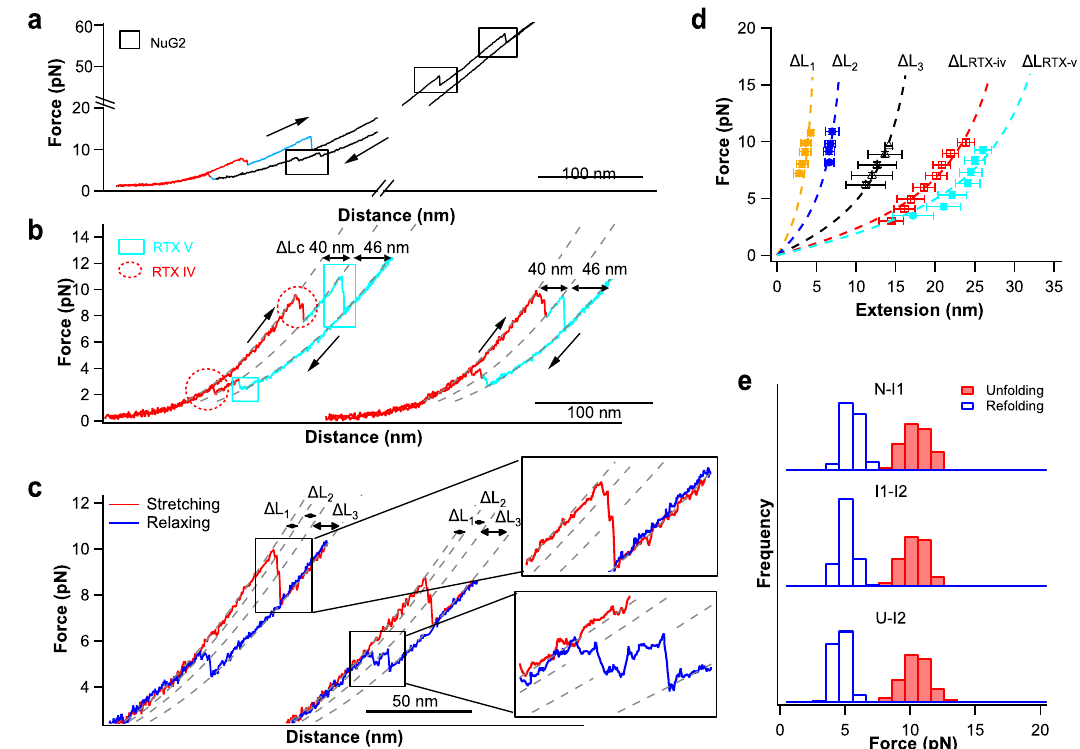
Fig. 3 Holo-RTX-iv-v is mechanically stable and can fold rapidly. a Representative F – D curves of the full-length NuG2-RTX-iv-v-NuG2. The unfolding and refolding events of NuG2 domains are colored in black and indicated by the squares, and the unfolding – folding of RTX-iv and RTX-v are colored in red and cyan, respectively. b Representative stretching and relaxation F – D curves showing the unfolding – folding of RTX-iv and RTX-v. The unfolding and folding events of RTX-iv are colored in red and indicated by circles, and the unfolding – folding events of RTX-v are colored in cyan and indicated by squares. For clarity, the two stretching – relaxation cycles are offset relative to each other. c F – D curves show that unfolding and folding of RTX-iv occur via a four-state pathway involving two intermediate states. The stretching – relaxation curves shown herein were limited to below 11 – 12 pN so that only RTX-iv unfolds and refolds, while RTX-v remained folded throughout. Insets show the zoomed view of the F – D curves showing the four-state unfolding and folding. Gray dashed lines in ( b , c ) are pseudo-worm-like chain (WLC) fi ts to the F – D curves. d Force – extension relationships of the (un)folding of RTX-iv-v. WLC fi ts (dashed lines) to the experimental data measured a Δ Lc - RTX-iv of 39.9 ± 0.8 nm ( n = 37) and Δ Lc - RTX-v of 46.2 ± 0.9 nm ( n = 42), respectively. WLC fi ts to the unfolding events involving intermediate states revealed Δ Lc1 of 6.5 ± 0.9 nm ( n = 87, from the native state to the fi rst intermediate state, N-I1), Δ Lc2 of 11.3 ± 0.7 nm ( n = 91, from the fi rst intermediate state to the second intermediate state, I1 – I2), Δ Lc3 of 23.5 ± 0.5 nm ( n = 115, from the second intermediate state to the unfolded state, I2-U), respectively. The error bars indicate standard deviations. e Histograms of unfolding and refolding forces of RTX-iv at a pulling speed of 50 nm/s. The number of unfolding and refolding events is shown in Supplementary Table